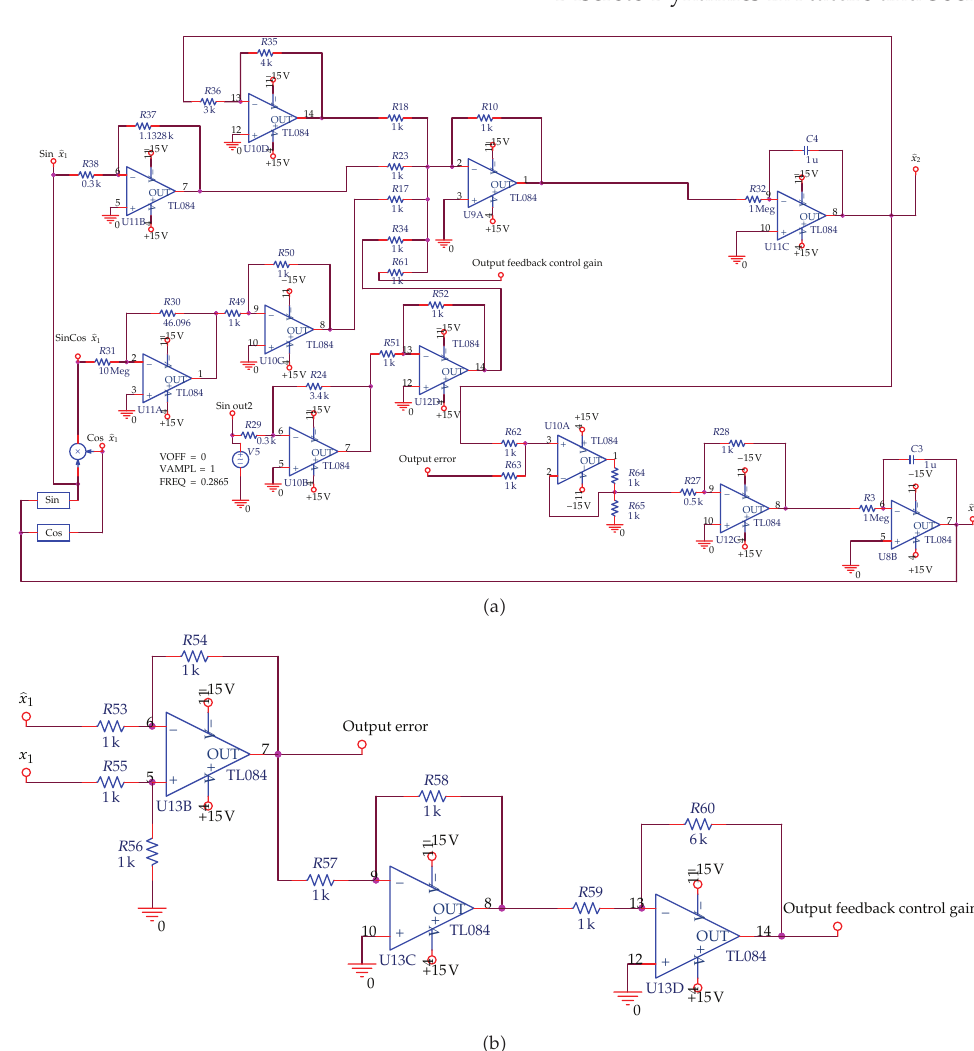
Figure 4: (cid:2) a (cid:3) The slave electronic HPS system. (cid:2) b (cid:3) The output error state and output error feedback control